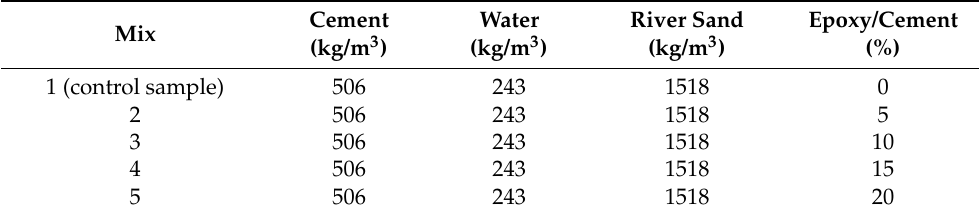
Table 2. Mix proportions of the self-healing